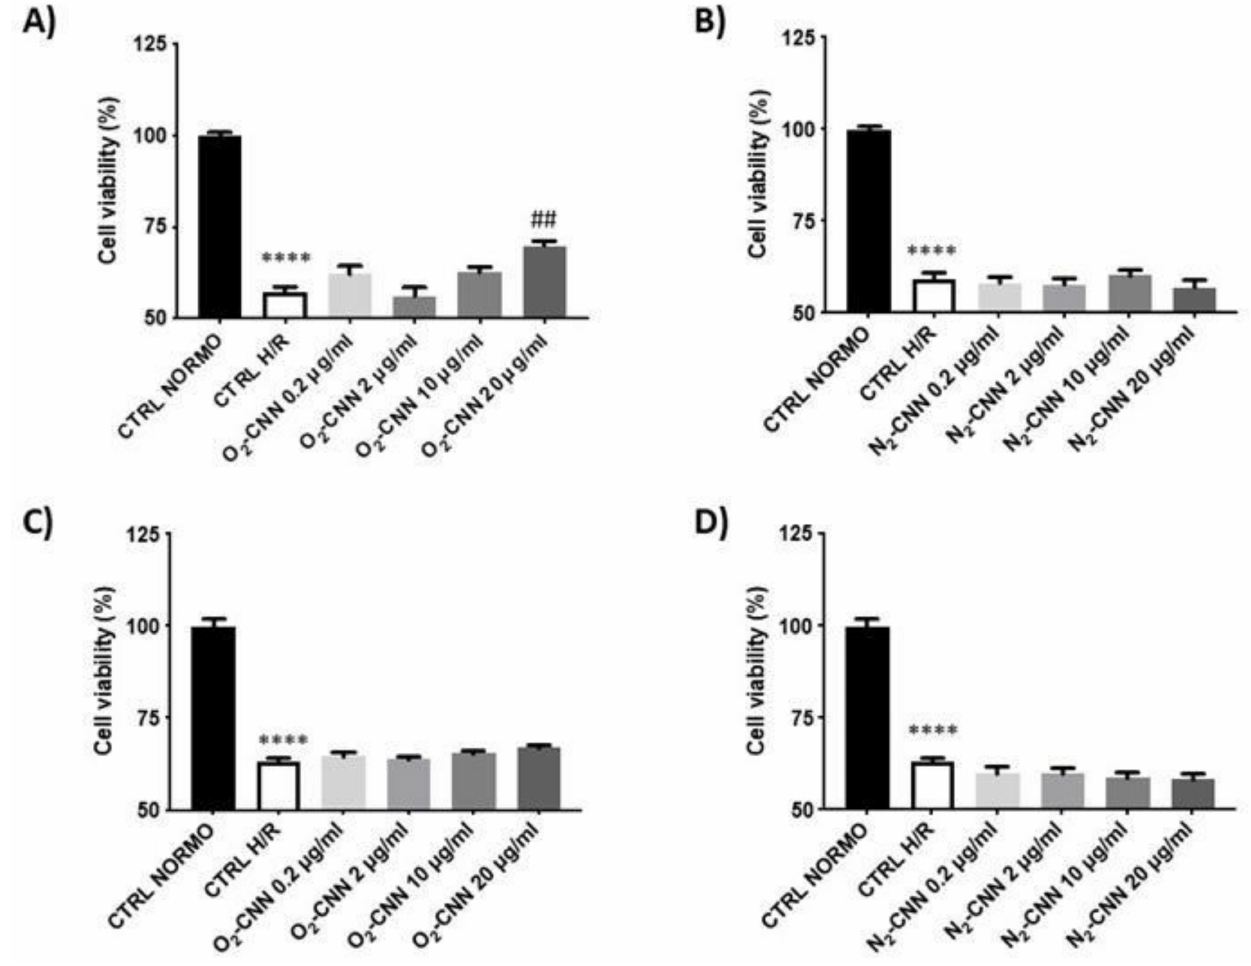
Figure 7. CNN post-treated cells in H/R conditions. ( A , B ): O 2 and N 2 CNN post-treated H9c2 in H/R conditions. ( C , D ): O 2 and N 2 CNN post-treated HMEC in H/R conditions. **** p < 0.0001 vs. CTRL NORMO; ## p < 0.0001 vs. CTRL H/R. Data were expressed as mean ± SE. Data were normalized to the mean value in control conditions (CTRL NORMO) and expressed as a